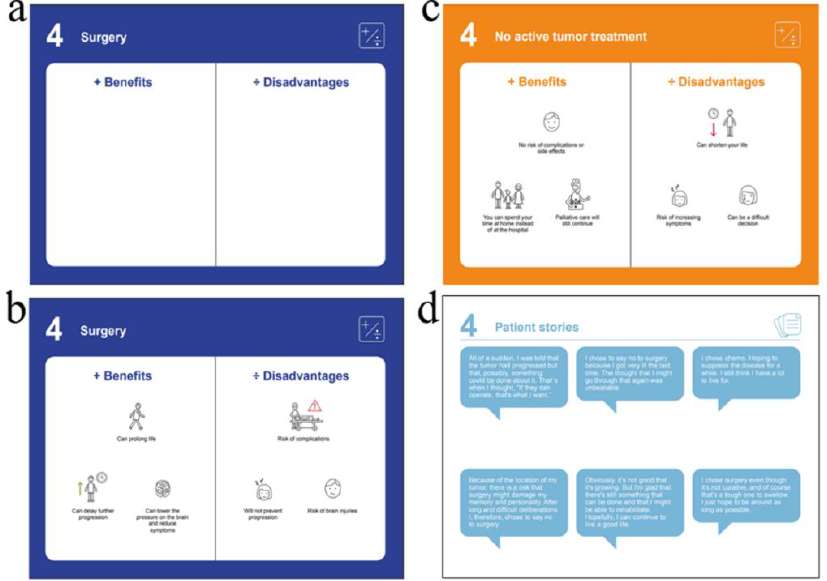
Figure 3. A surgical option card with only the option heading ( a ), the surgical ( b ), and no active tumor treatment ( c ) card populated with the benefits and disadvantages selected during the PtDA development process, and the patient narrative card ( d ).